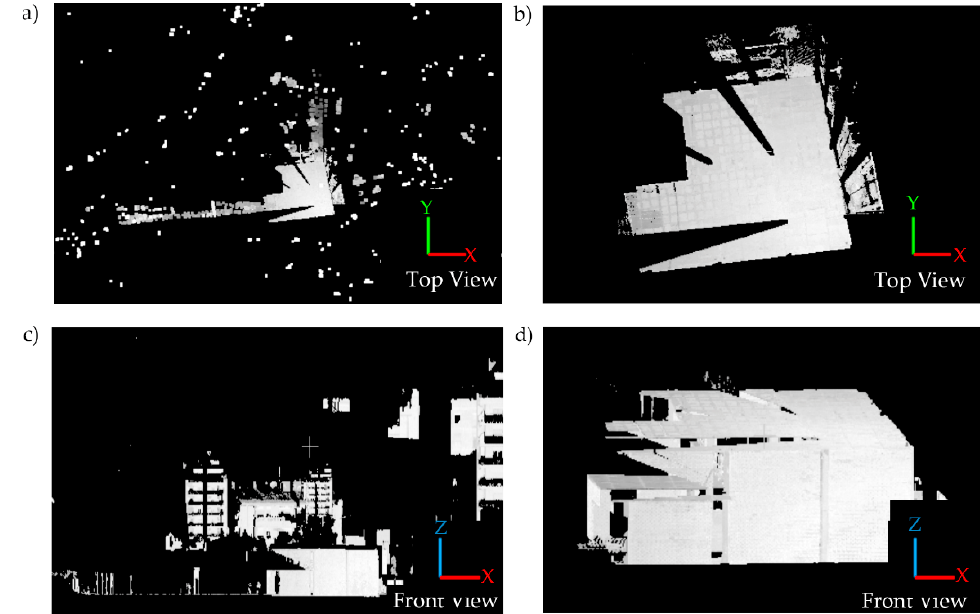
Figure 5. Passthrough filter based on the coordinate histograms. ( a ) Top view of raw scanned data with scatter. ( b ) Top view of scanned data after filter by X -coordinates histogram ( c ) Front view of raw scanned data with scatter. ( d ) Result after coordinates histogram filter.